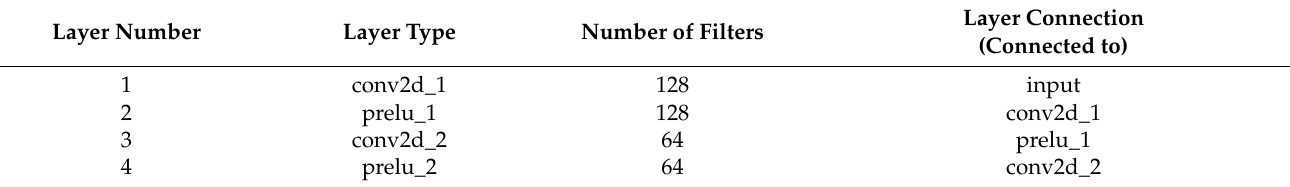
Table 5. Description of a convolution block of the generator.